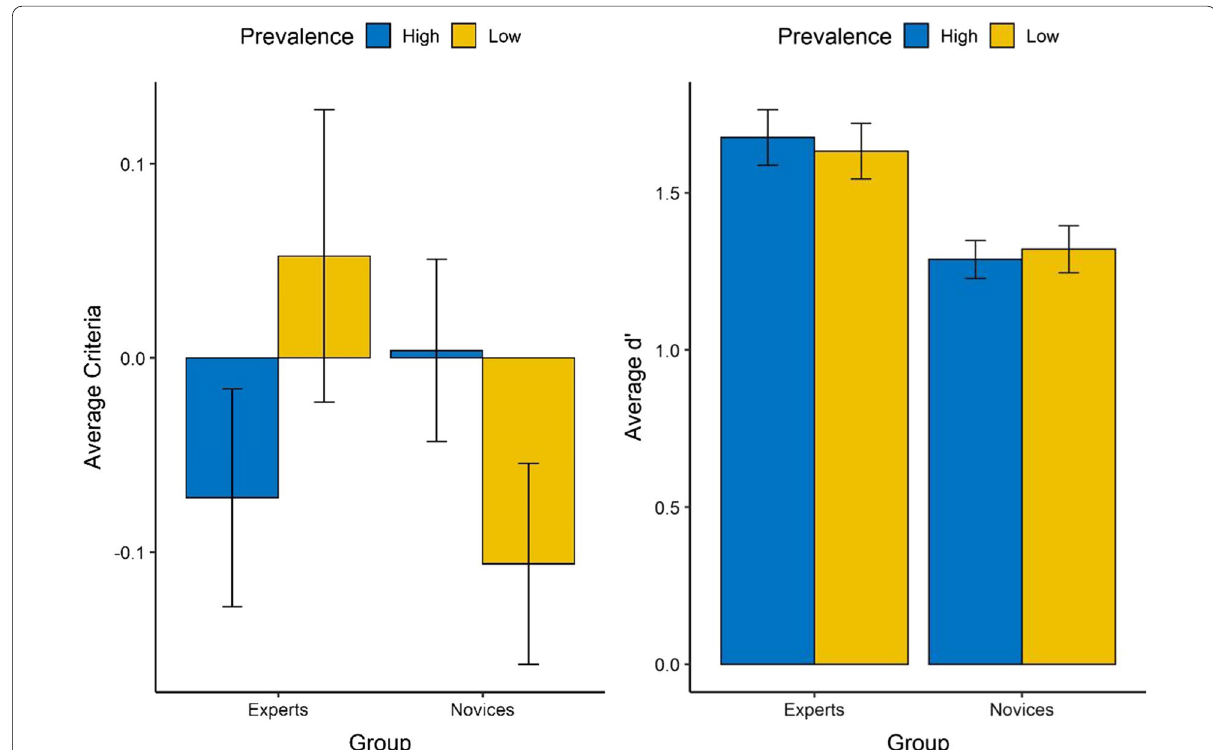
Fig. 3 The average criteria and d’ for the group of experts and novices as a function of the level of prevalence. The error bar represents standard